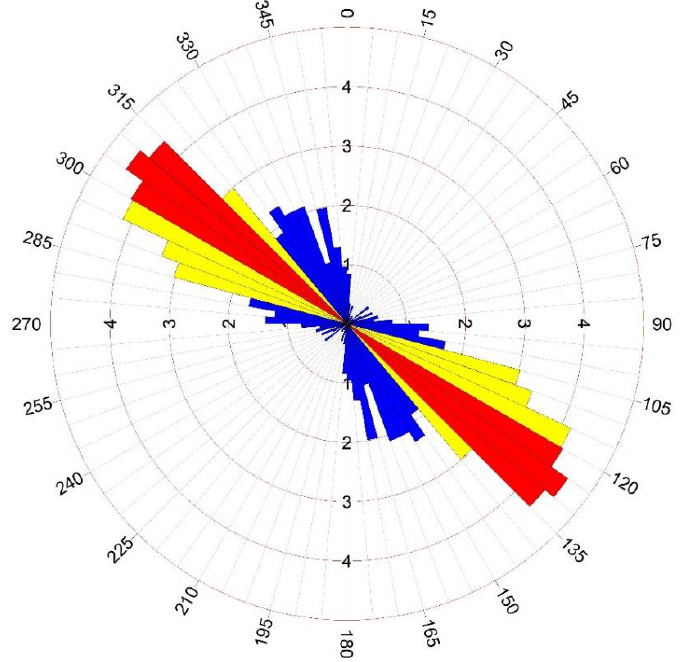
Figure 5. Rose diagram of all faults in the study area. Faults are divided into three categories based on frequency percentage: low frequency, medium and frequent, which are distinguished by blue, yellow and red colors, respectively.